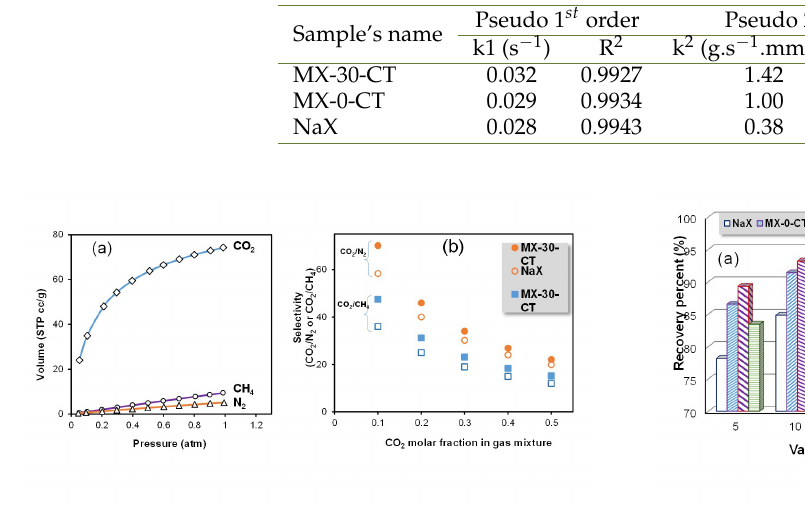
Table 2. Rate constants of the adsorption of CO 2 on various zeolite X samples at 30°C.